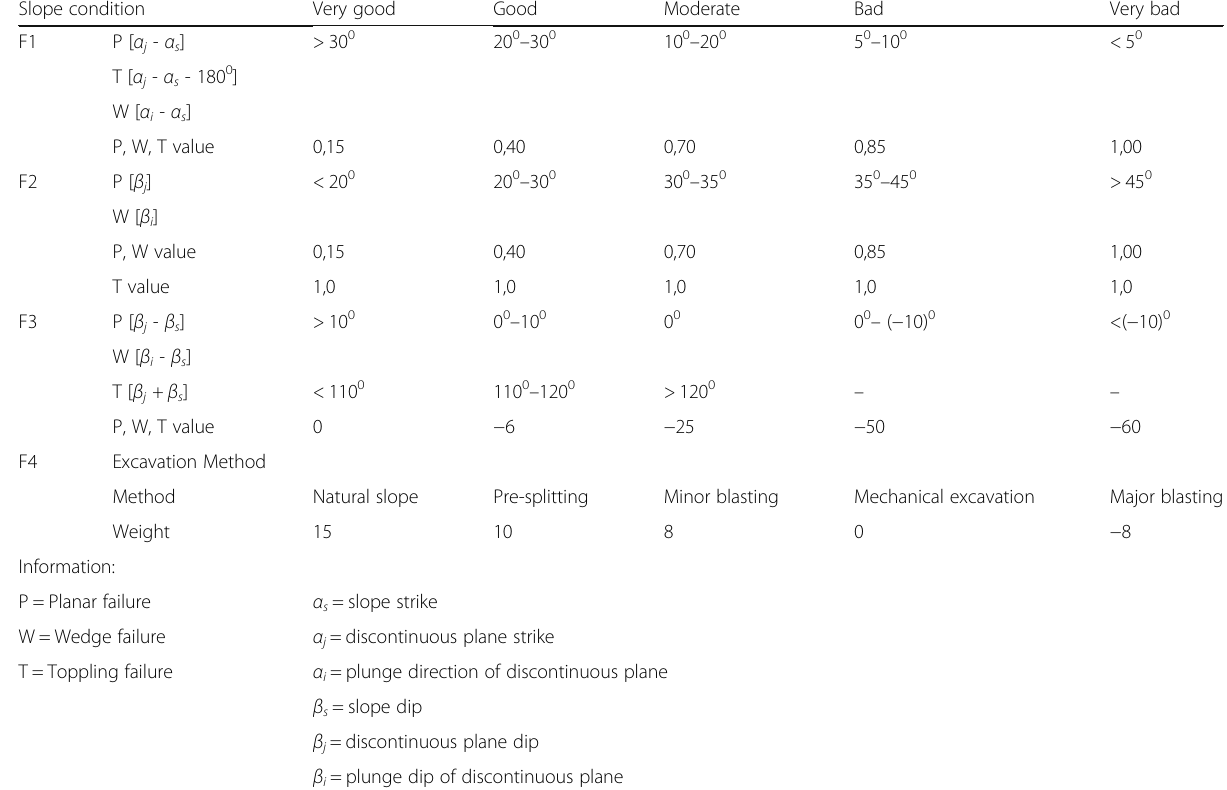
Table 9 SMR Adjustment Factor classification and the hazard rating (Romana 1993) Slope condition